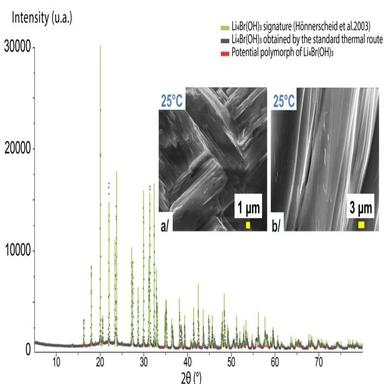
XRD diffractogram of the 3LiOH ·LiBr mixture after the thermal treatment inside the SEM chamber under low pressure condition confirming the Li4Br(OH)3 obtention as described by with its related morphology.